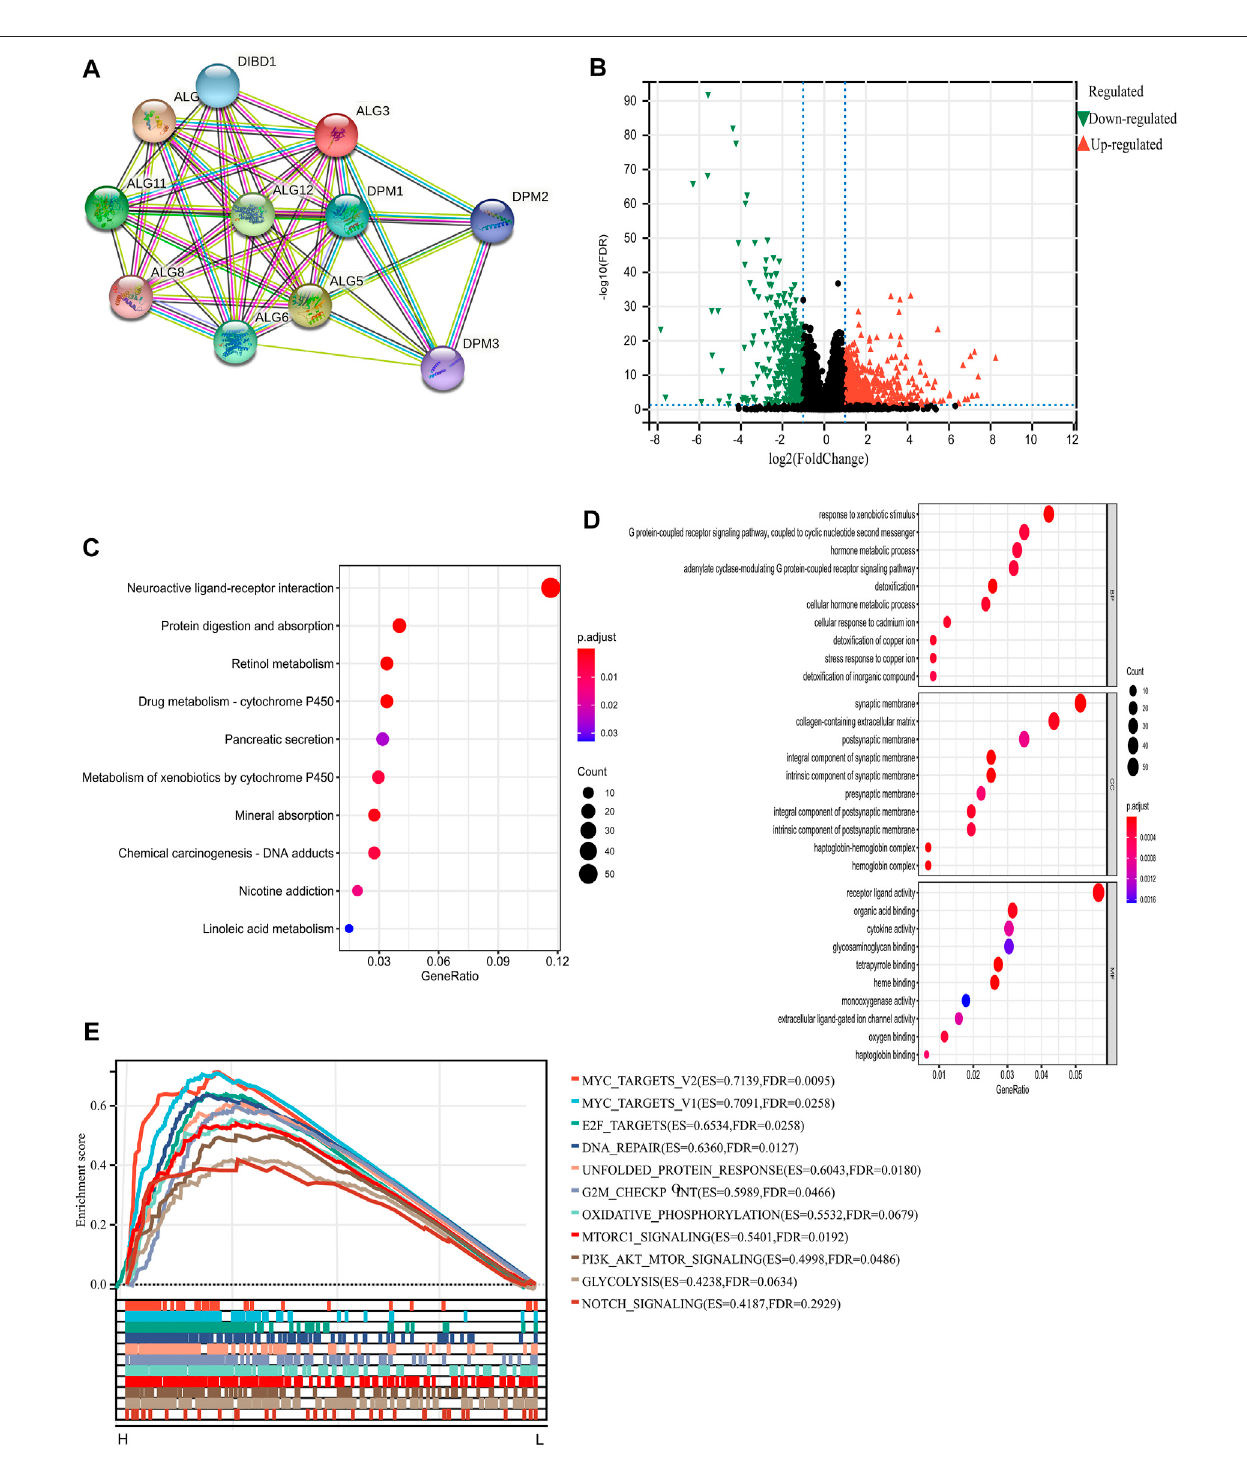
FIGURE 5 | PPI and functional enrichment analyses of ALG3 in HCC. (A) STRING tool to construct a network of the interaction between ALG3 and other proteins. (B) Volcano plot depicting the DEGs. (C) Kyoto Encyclopedia of Genes and Genomes (KEGG) pathway, (D) Gene Ontology (GO) enrichment, and (E) gene set enrichment analysis (GSEA) of